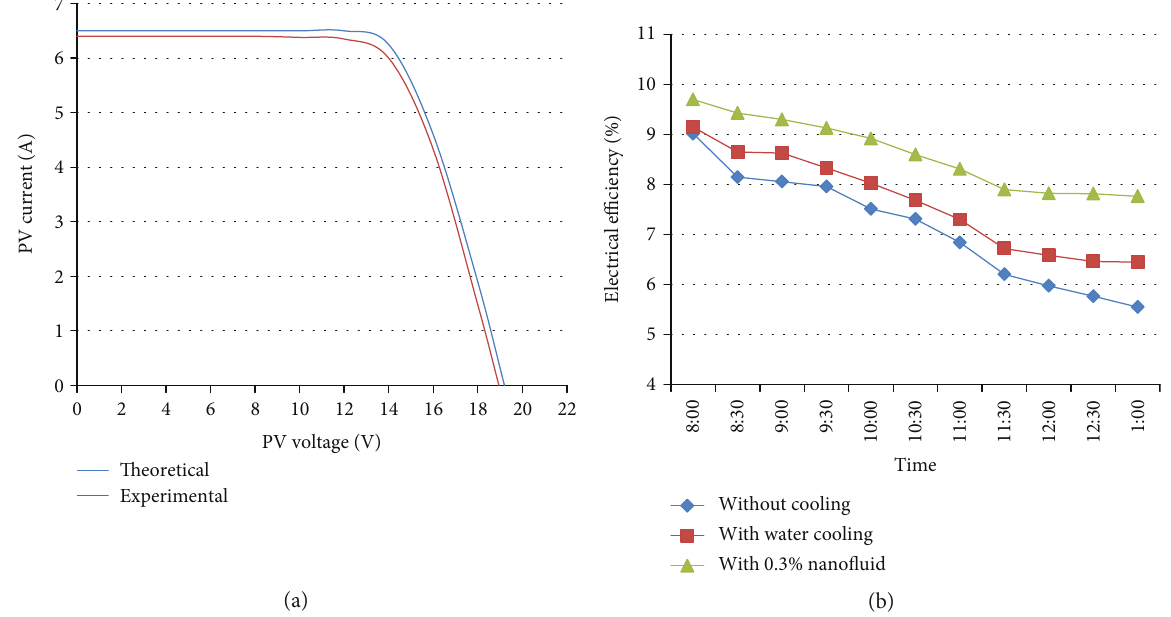
Figure 15: (a) Theoretical and experimental results comparison of I - V at 1000 W/m 2 and 70 ° C. (b) Comparison of electrical e ffi ciency of PV/T without water, with water (2 L/min), and with Zn-H